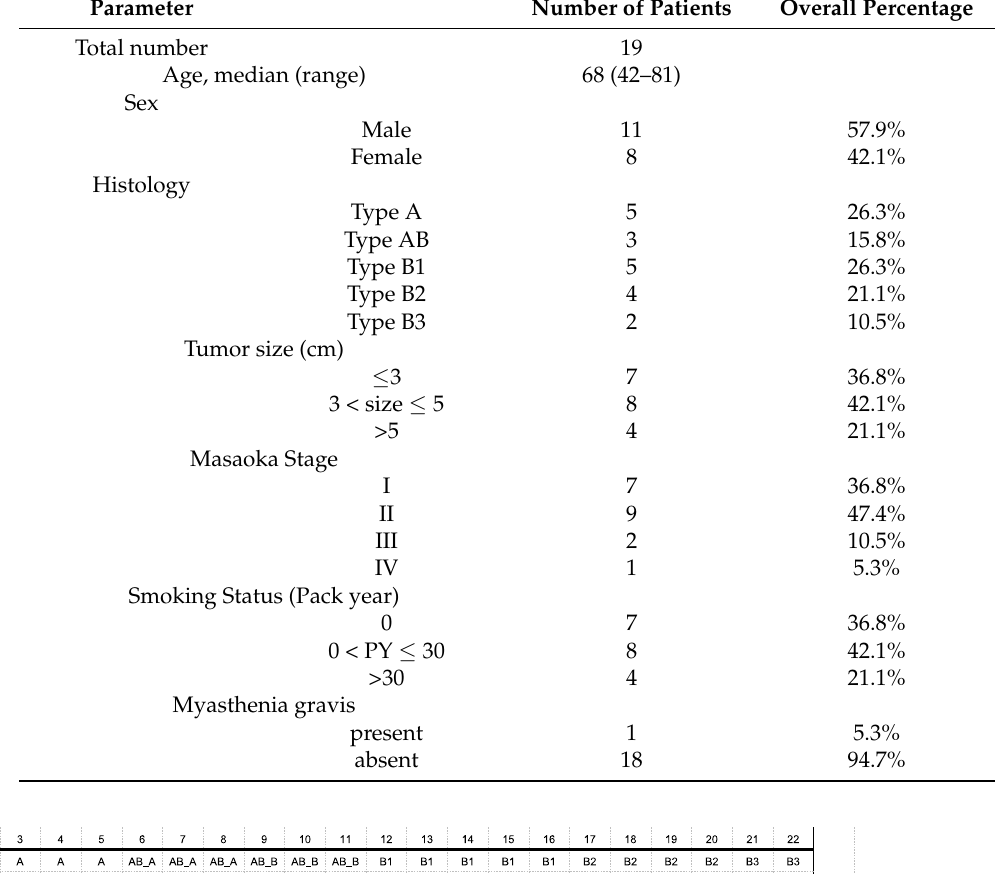
Table 1. Patient characteristics.